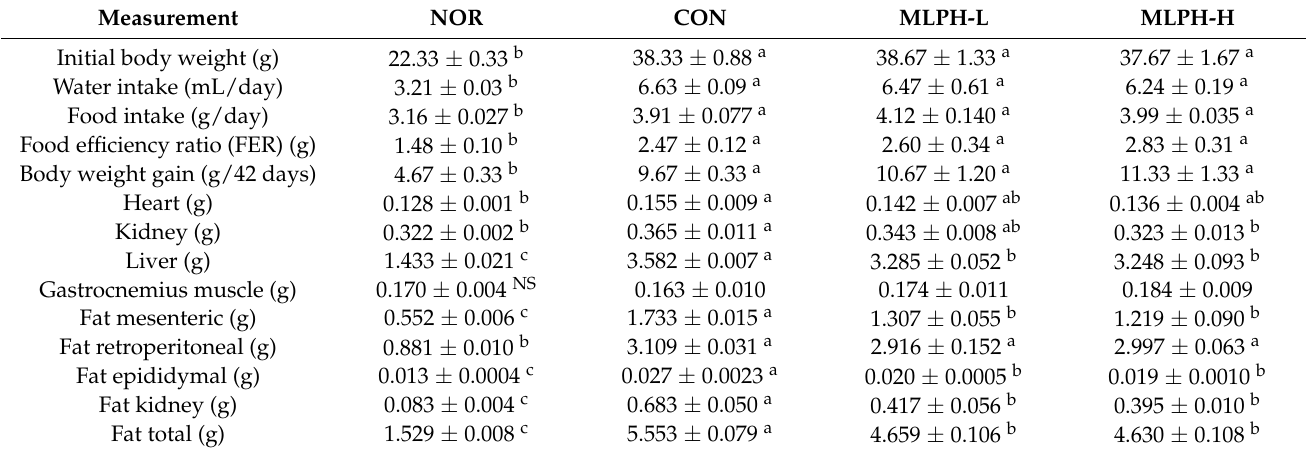
Table 2. Food efficiency ratio (FER), body weight, organ weight, and fat content in NOR, CON, and MLPH groups after treatment with protamex extract at a low or high dose for 6 weeks in ob / ob mice fed a standard